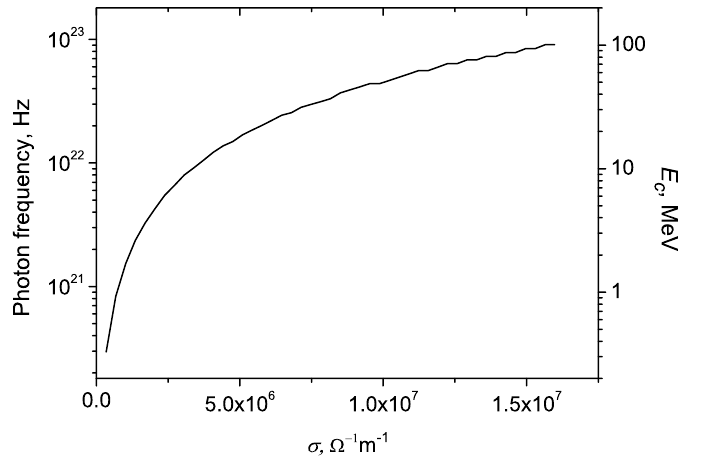
2 π f 3.1 10 10 Hz, r 0 = 0.01 m. = = ·